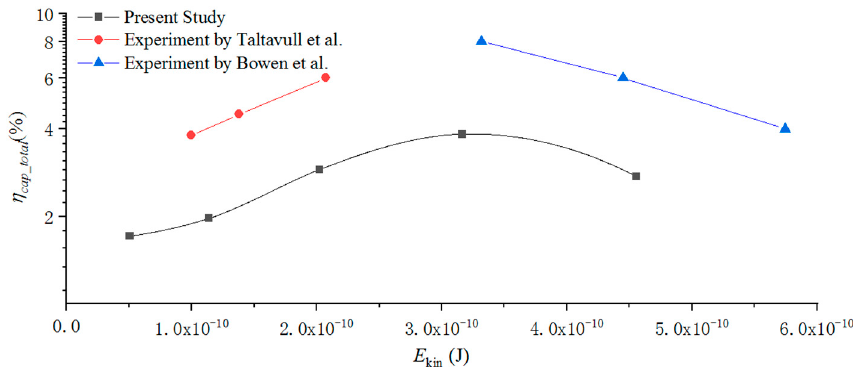
Figure 13. Total capture efficiency in this study compared with data from Taltavull [31] and Bowen [32].